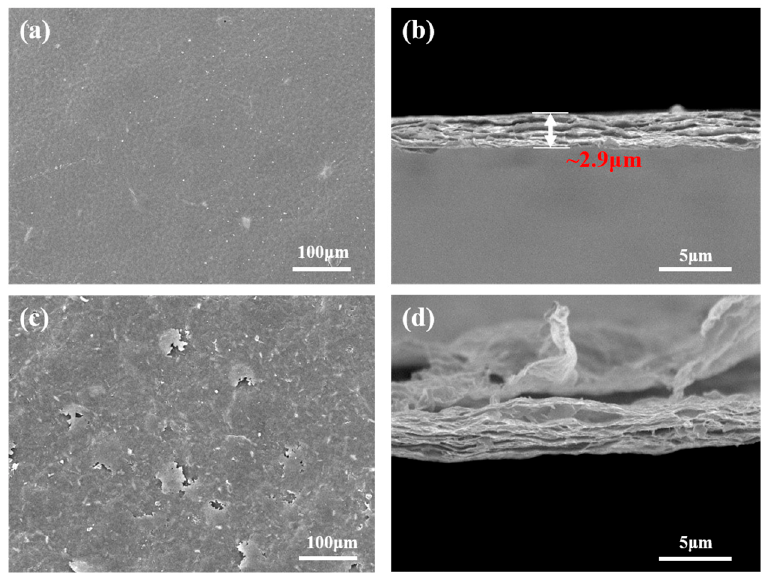
Figure 8. SEM images of ( a , b ) RGO after vacuum drying at 150 °C and ( c , d ) RGO after heat treatment at 500 °C.